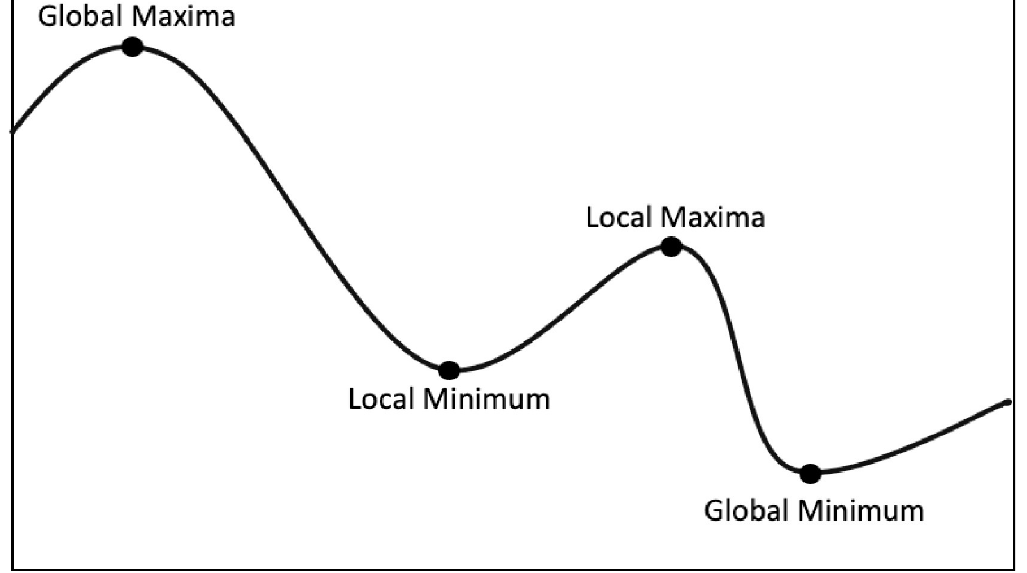
Fig 29. Hill-Climbing